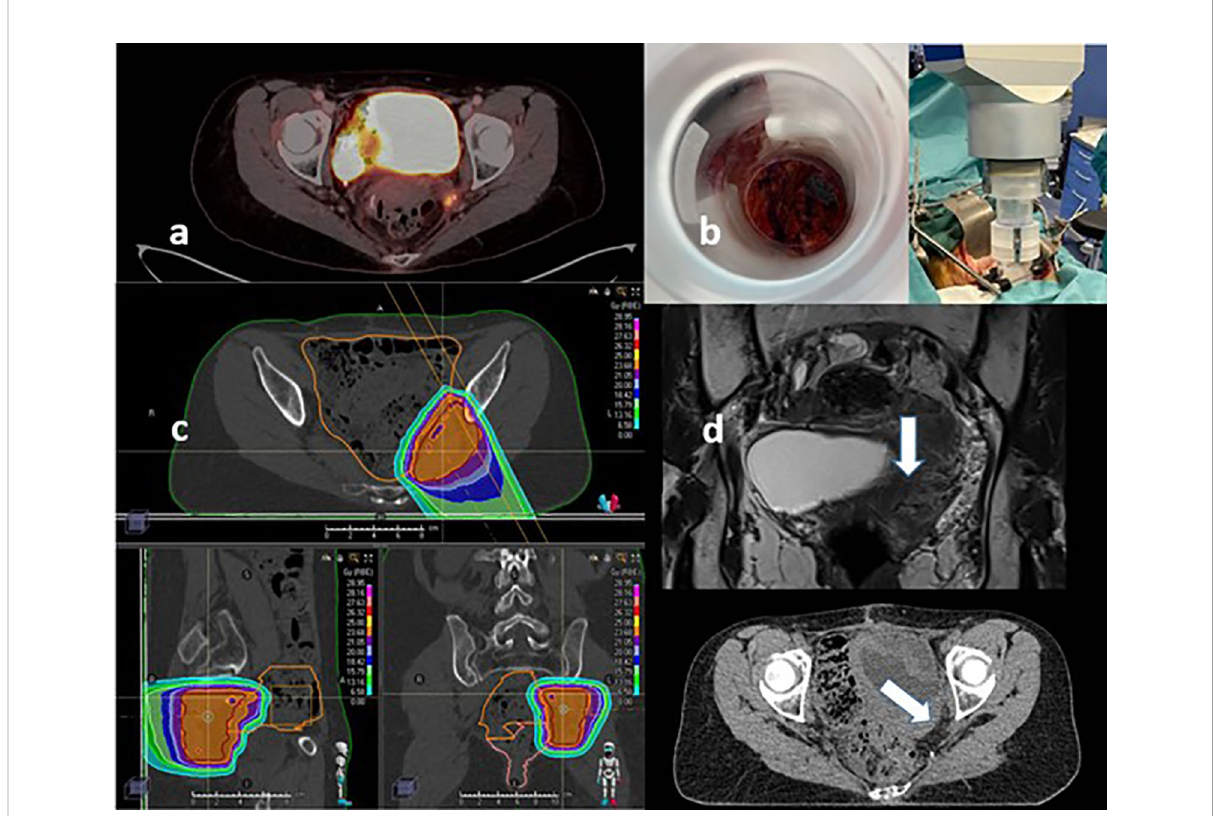
FIGURE 3 Oligo-recurrent rectal cancer treated with proton therapy and IOeRT under re-irradiation conditions (previous treatment components included neoadjuvant chemoradiation, hypofractionated perioperative high-dose rate brachytherapy, and stereotactic body radiotherapy). (A) Oligo- recurrent pelvic disease for small bowel displacement progressing after previous tri-irradiation from the proton beam. (B) Beam ’ s eye view of the target and post-docking view of the surgical area. (C) Proton beam fi eld arrangement and dosimetric distribution. (D) Spacer made of epiplon at the time of surgical resection and IOeRT